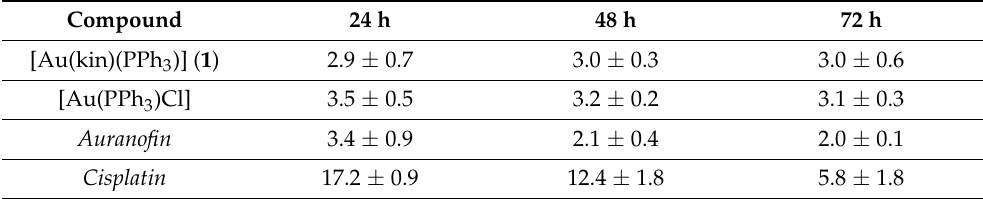
Table 3. The results of time-dependent in vitro cytotoxicity against the A2780 cell line.